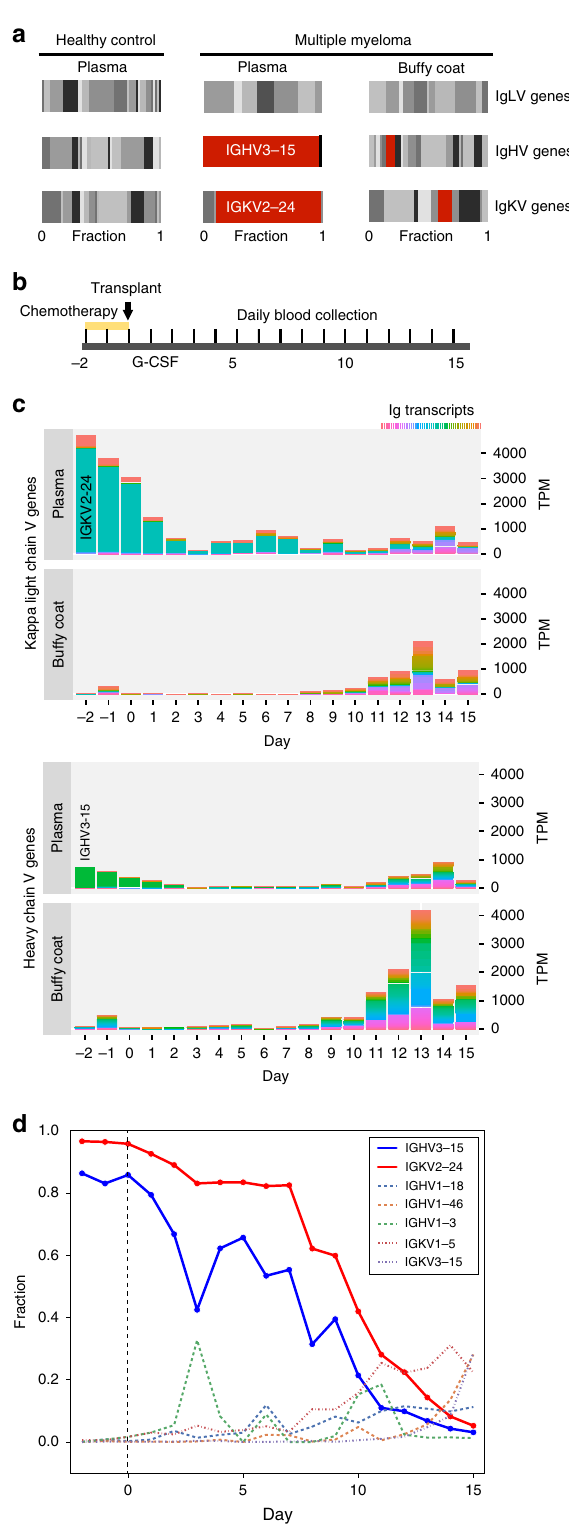
Fig. 2 cf-mRNA transcriptome re fl ects dynamical changes of Ig transcripts derived from the BM. a Matching cf-mRNA and buffy coat samples from a multiple myeloma patient (day − 2) were analyzed by RNA- Seq. Fraction of transcripts from the variable regions of the immunoglobulin heavy and light chains identi fi ed in plasma and buffy coat samples are shown (center and right panels). Clonally ampli fi ed transcripts are indicated in red and dominated the representation of Ig transcripts in cf-mRNA of the MM patient. Levels of Ig transcripts in plasma of a healthy individual (left panel) are shown as reference. b Schematic of the therapeutic treatment performed in MM patients. Melphalan-mediated BM ablation started at day − 2, autologous stem cell transplant was performed at day 0. Steroids and G-CSF were then administered as supportive care. Blood was collected every day during the study. c . Bar graphs showing the normalized values (TPM, Y axis) of Ig transcripts detected by RNA-Seq in paired plasma and buffy coat samples throughout the treatment. The repertoire of variable regions of Ig heavy chain and Ig kappa light chain are shown in a color gradient. Dominant transcripts identi fi ed in plasma are indicated. Day of blood collection with respect to transplant is indicated in the X axis. d Fraction of transcripts from variable Ig regions in cf-mRNA during BM ablation and transplant. Day of blood collection with respect to transplant is indicated in the X axis. Dominant Ig transcripts, shown in solid blue and red lines, decrease after melphalan-mediated BM